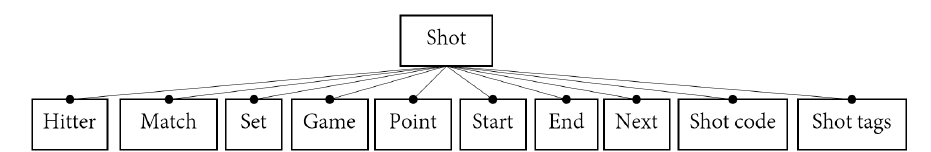
Figure 4. Feature diagram of a shot.